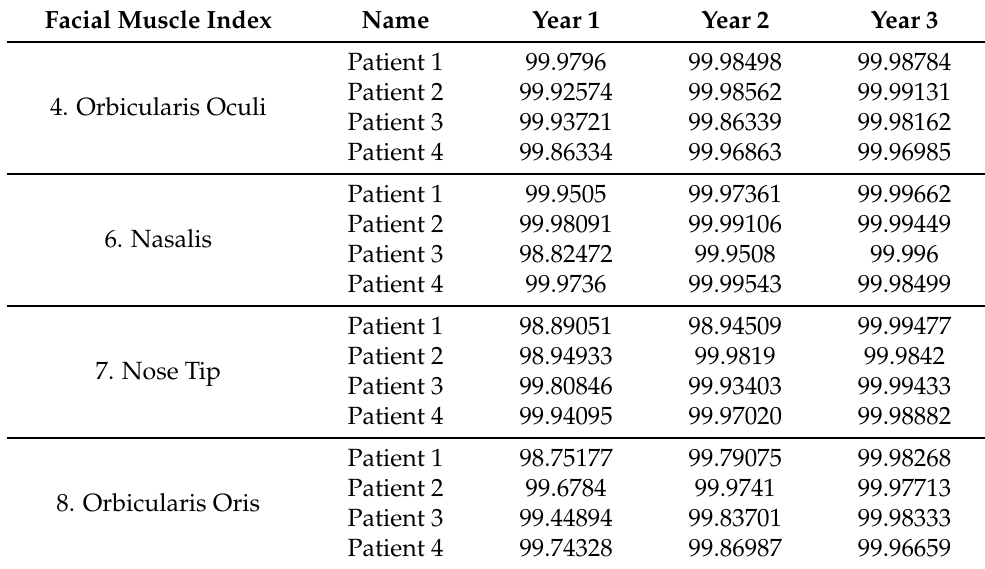
Table 7. Angle symmetry results for each facial muscle of patients by year in smile expression.